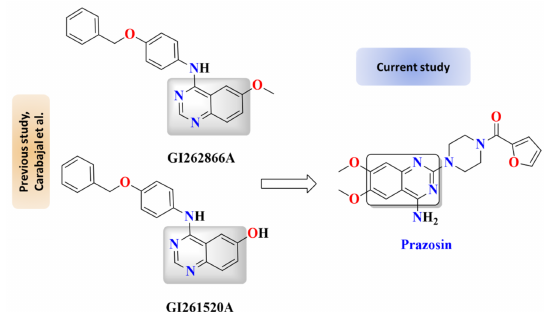
Figure 1. Salmonella employs different systems to regulate its virulence. The Salmonella PhoP/PhoQ regulatory system and quorum sensing system (QS) regulate the expression of virulence encoding genes, and their targeting could dramatically diminish the bacterial virulence. In addition to bacterial systems, Salmonella pathogenesis is enhanced by its ability to spy on the host systems, sensing adrener- gic hormones using membranal receptors. It was shown that compounds GI262866A and GI261520A exhibit anti-virulence activities via targeting the Salmonella PhoP/PhoQ regulatory system [45]. In the current study, prazosin shares quinazoline moiety with compounds GI262866A and GI261520A, and it can significantly diminish bacterial virulence via targeting QS and preventing bacterial espionage.